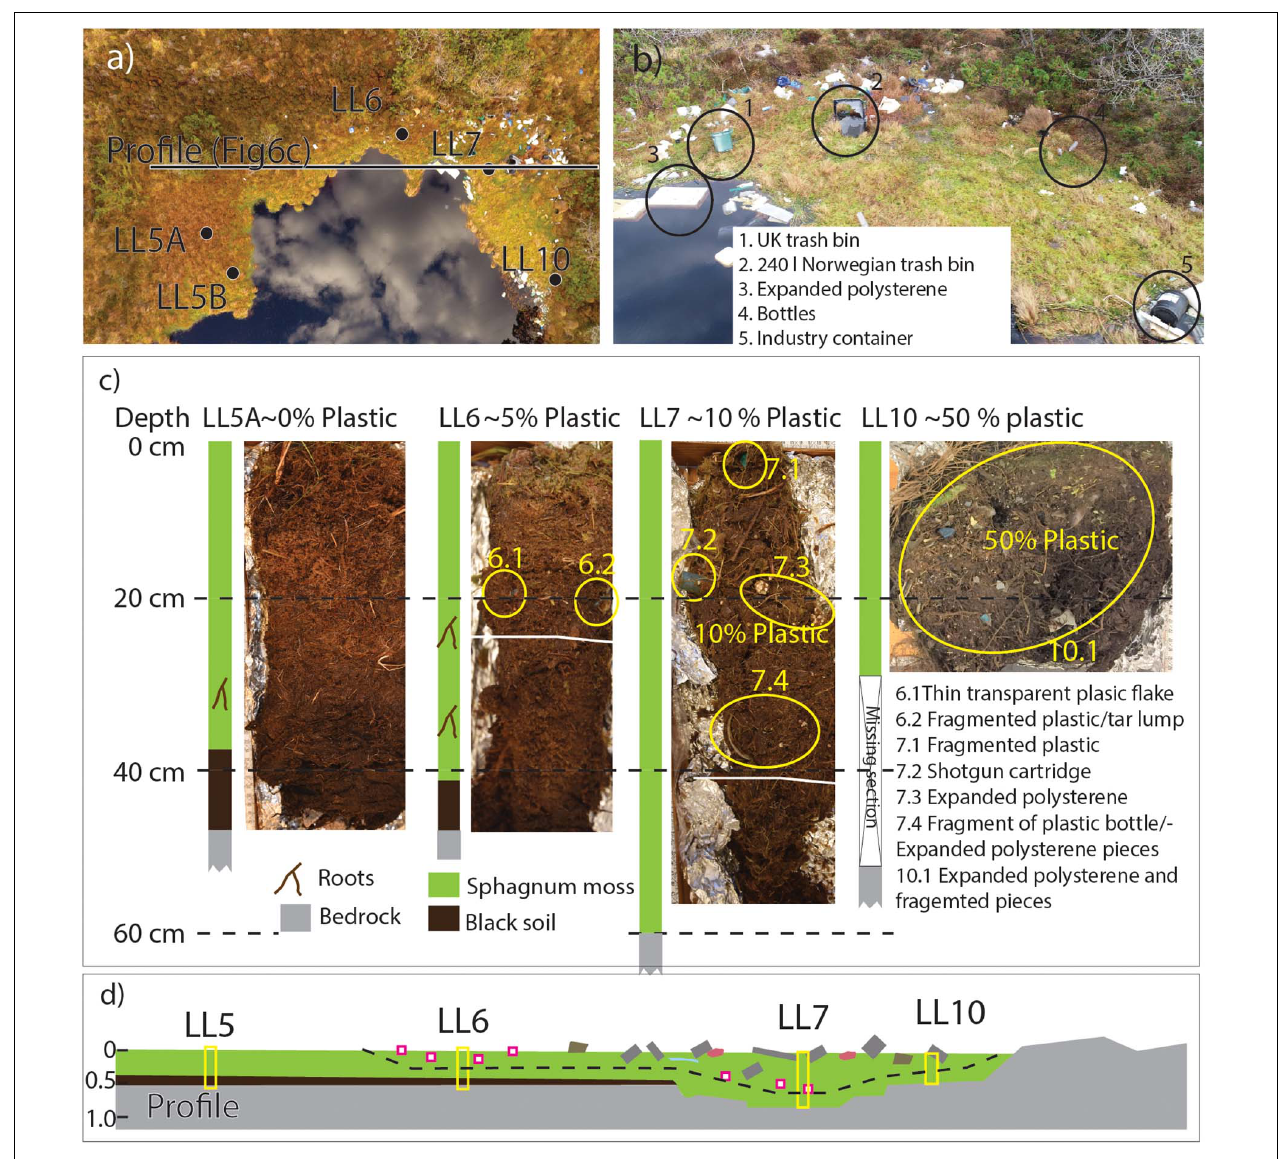
FIGURE 6 | Samples and field work in northern part of pond Zone 3. (a) Drone photo of a bog in the northern part of the pond. Note decreasing amount of surface litter from east to west (the image is oriented NNW-SSE), subsurface soil core sample sites and profile ( c and d ) are denoted. (b) Close up drone photo of the NE part of pond displaying the high amount of litter observed on surface. (c) Cores LL5, LL6, LL7 and LL10. Samples display clearly how plastic is incorporated into the soil. (d) Profile based on the soil profiles and steel probe